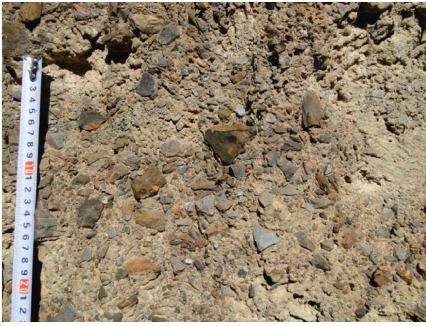
Figure 1: Soil-rock mixtures seen in engineering.